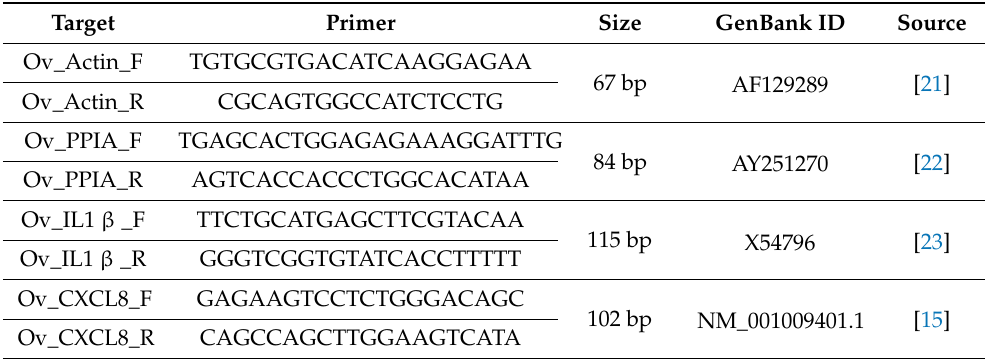
Table 1. Primers used in the qPCR